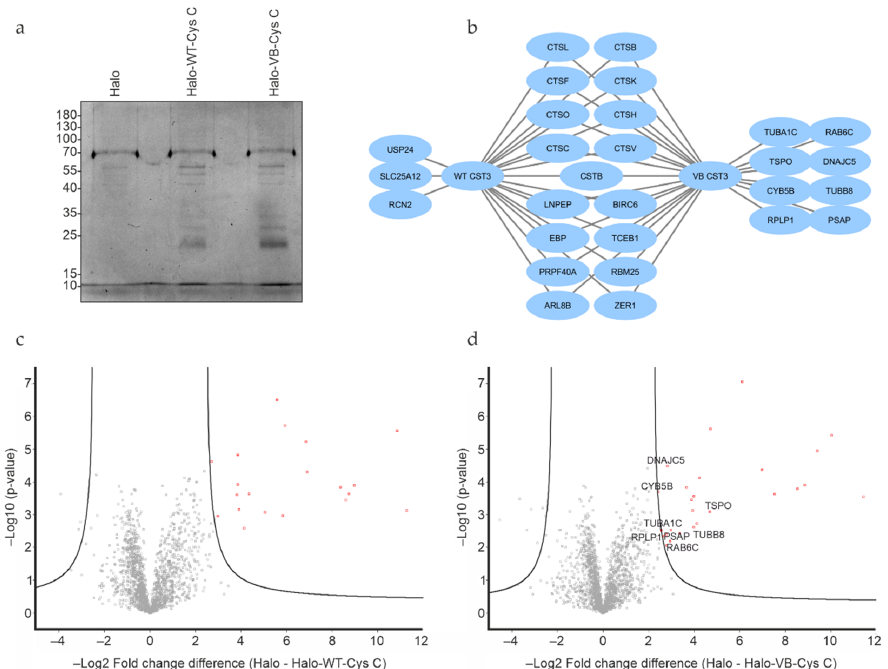
Figure 2. Protein interaction analysis of WT and variant B cystatin C by mass spectrometry. ( a ) Silver stain analysis of eluates from Halo-tag protein pull down experiments indicate multiple proteins eluted from pull down assays using both fusion constructs. ( b ) Visual representation of interacting proteins identified from Halo-tag pull down analysis using WT or variant B cystatin C fusion constructs. Volcano plots of mass spectrometry results of eluates from Halo-tag pull down analysis using WT ( c ) or variant B ( d ) cystatin C fusion constructs. Proteins exclusively pulled down by variant B cystatin C marked in plot. Cells transfected with plasmid encoding Halo-tag only were used as negative controls. All experiments were conducted in biological triplicates.